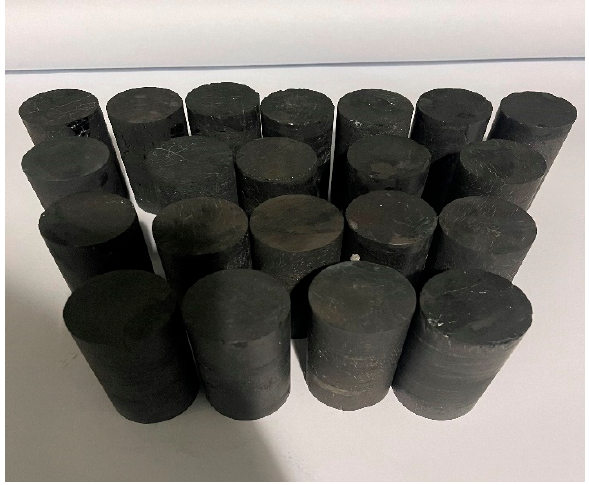
Figure 2. Prepared coal samples.